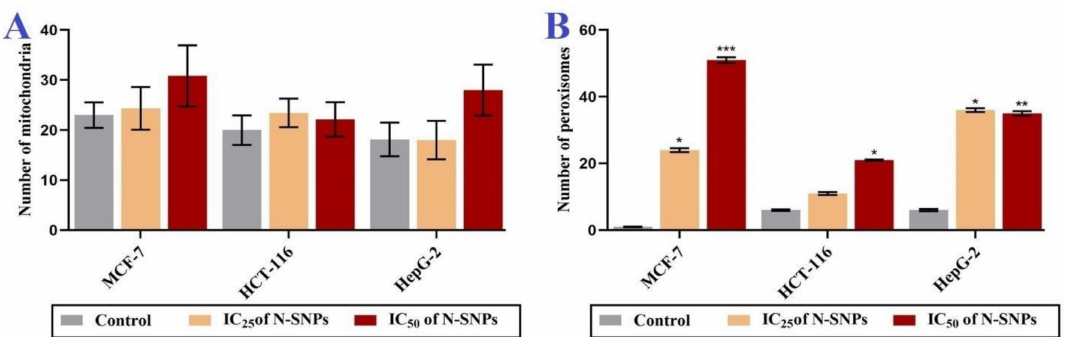
Figure 6. Changes in distribution of ( A ) number of mitochondria and ( B ) number of peroxisomes in MCF-7, HCT- 116, and HepG2 cells before and after treatment with N-SNPs at IC25 and IC50 for 24 h. Data represent averages of measurements from 10 cells and are presented as mean ± SEM. p -values were calculated versus untreated cells: *** p < 0.0001, ** p < 0.001, * p <